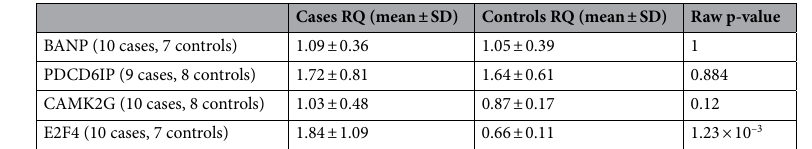
Table 3. Mean, standard deviation and p-values of the mRNAs from the qRT-PCR assay. Ten cases and eight controls were evaluated. The table shows the final size after qRT-PCR quality controls and removal of significant outliers. RQ relative quantification, SD standard